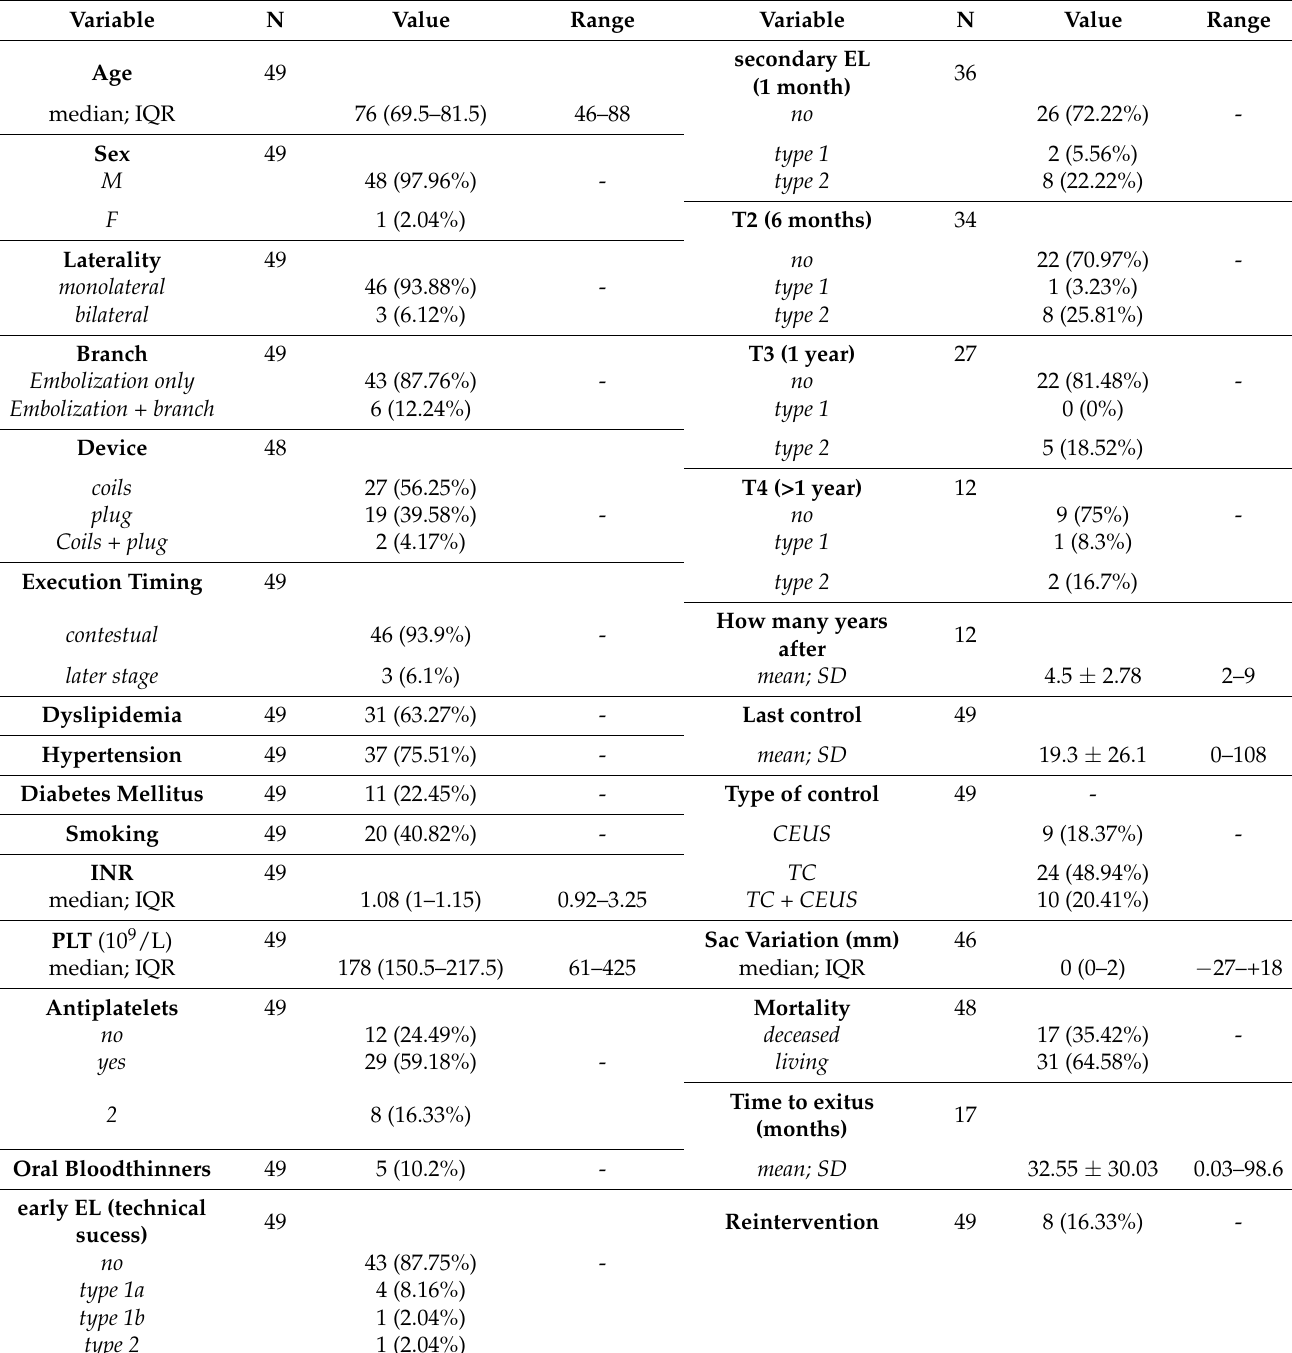
Table 1. Descriptive statistics of the 49 patients enrolled in the